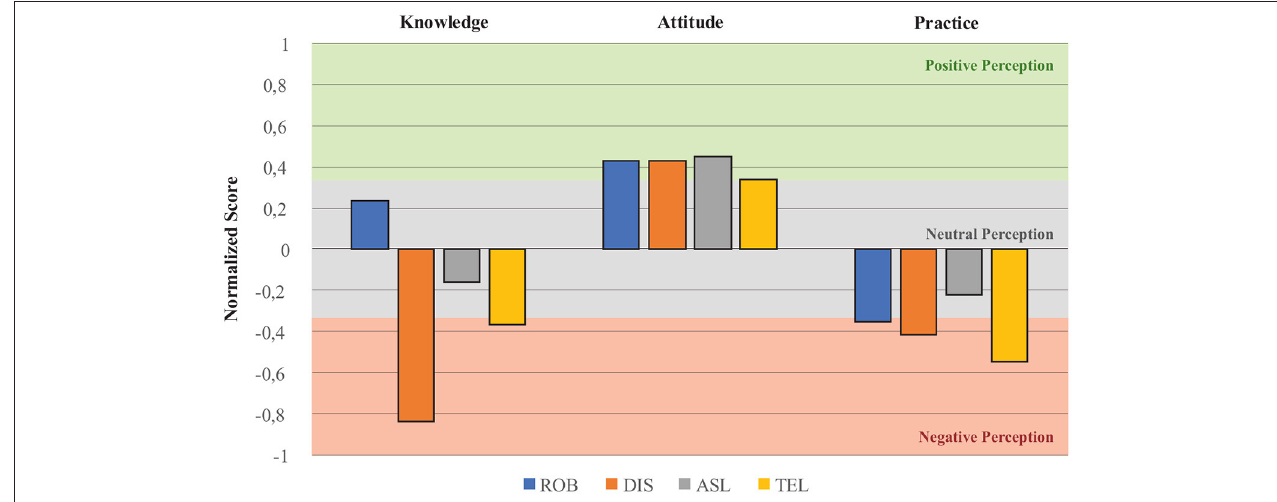
FIGURE 2 | Results of the Knowledge, Attitude, and Practice (KAP) survey. The scores for each type of robot were grouped and normalized to identify the overall perception. ROB stands for questions oriented to medical robotics. DIS stands for questions oriented to disinfection robots. ASL stands for questions oriented to assistance, service, and logistics robots. TEL stands for telemedicine and telepresence robots. The data standardization used the possible maximum and minimum values of each question, being inverted the values for questions formulated negatively.